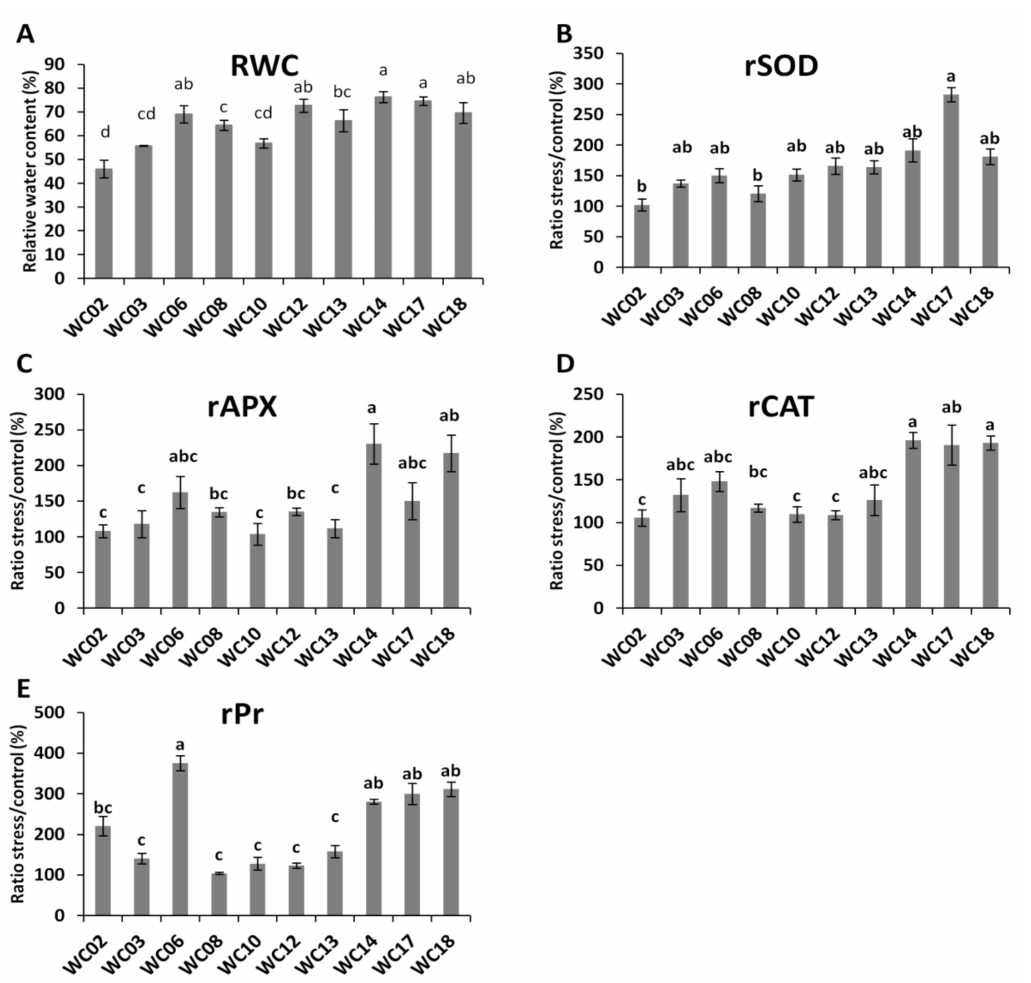
Figure 2. Effects of water deficit on physiological and biochemical traits in sesame genotypes. ( A ) relative water content (RWC); ( B ) relative SOD activity (rSOD); ( C ) relative APX activity (rAPX); ( D ) relative CAT activity (rCAT); ( E ) relative proline content (rPr). Different letters (a, b, c, d) above bars represent significant difference ( p < 0.05) between